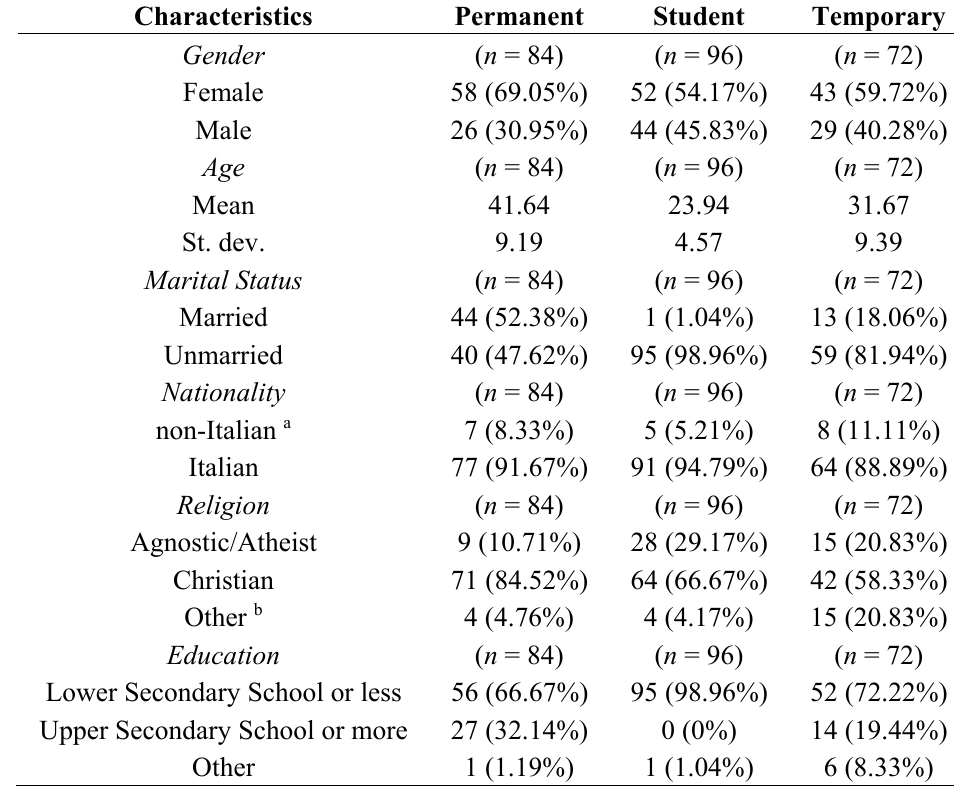
Table A1. Subjects’ socio-demographic characteristics.